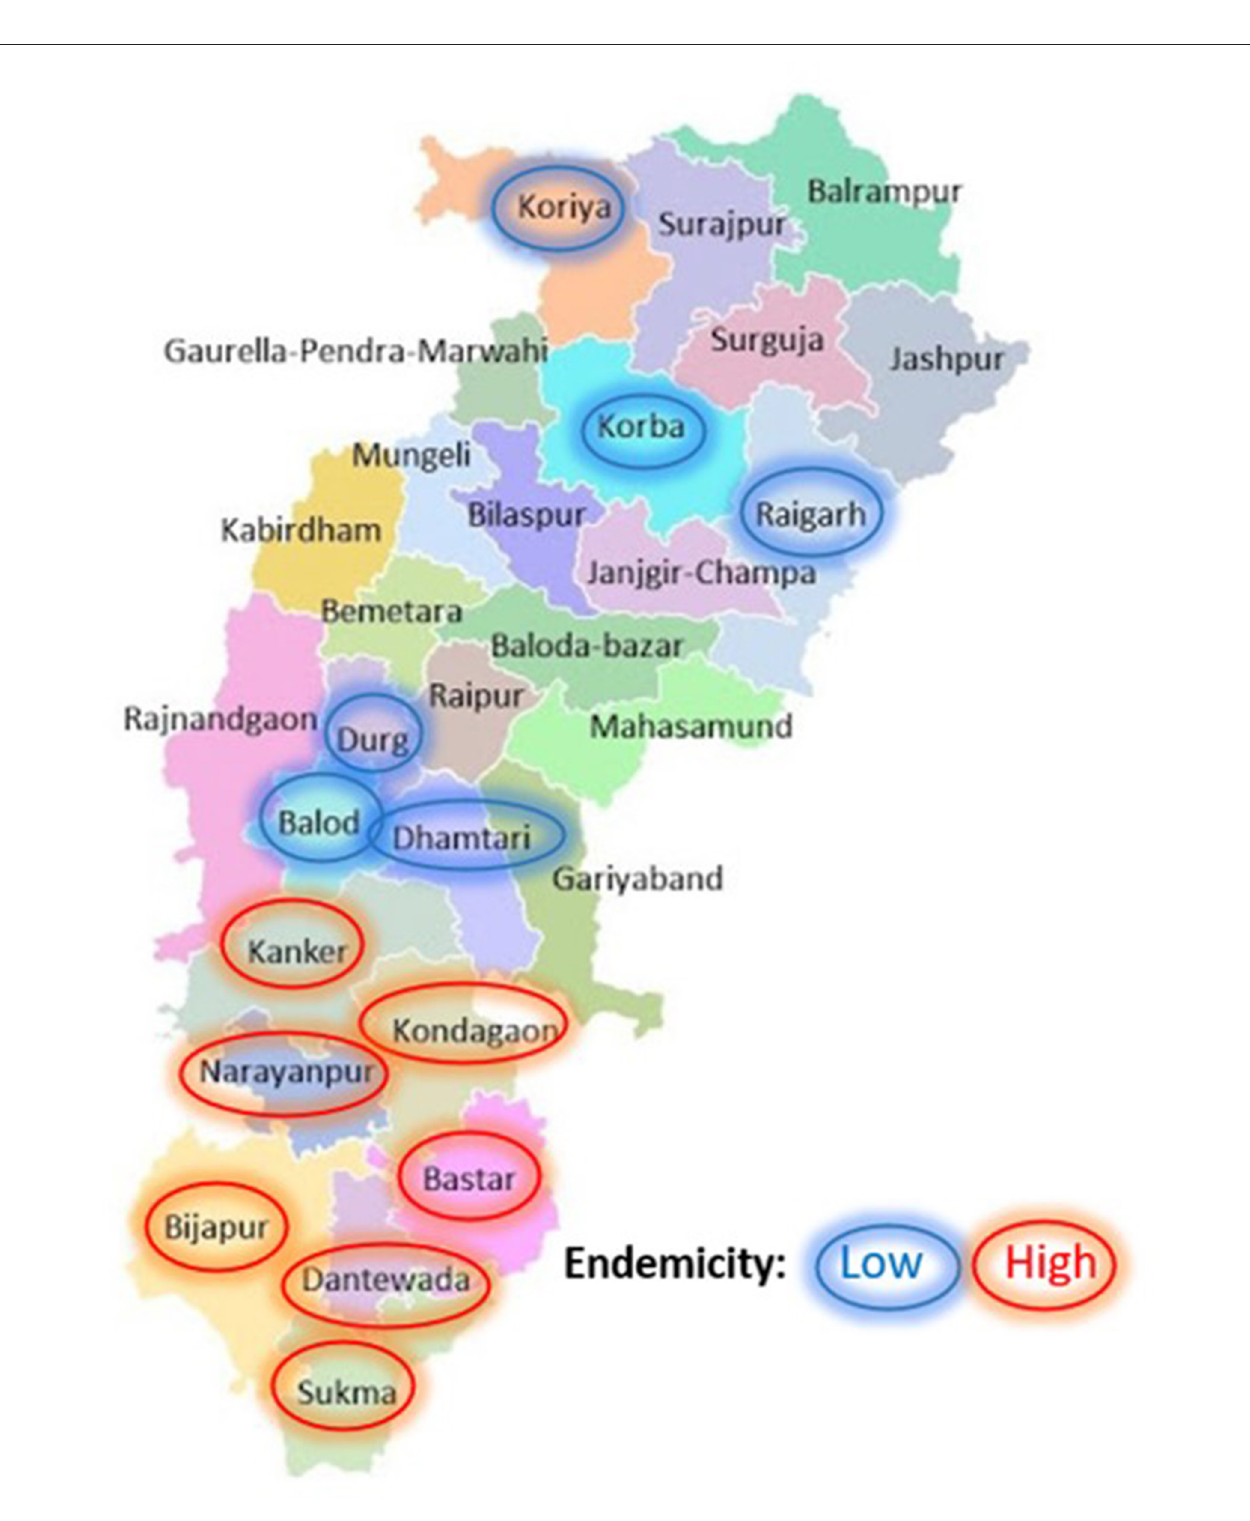
FIGURE 1 | Distribution of selected study districts and their endemicity. The study included mitanin from 13 districts, 6 low endemic (circled blue) and 7 high endemic (circled red) were included in the study.